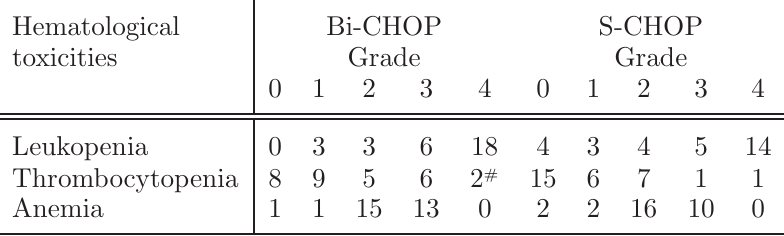
Table 4 Patient characteristics and immunohistochemistry classification.